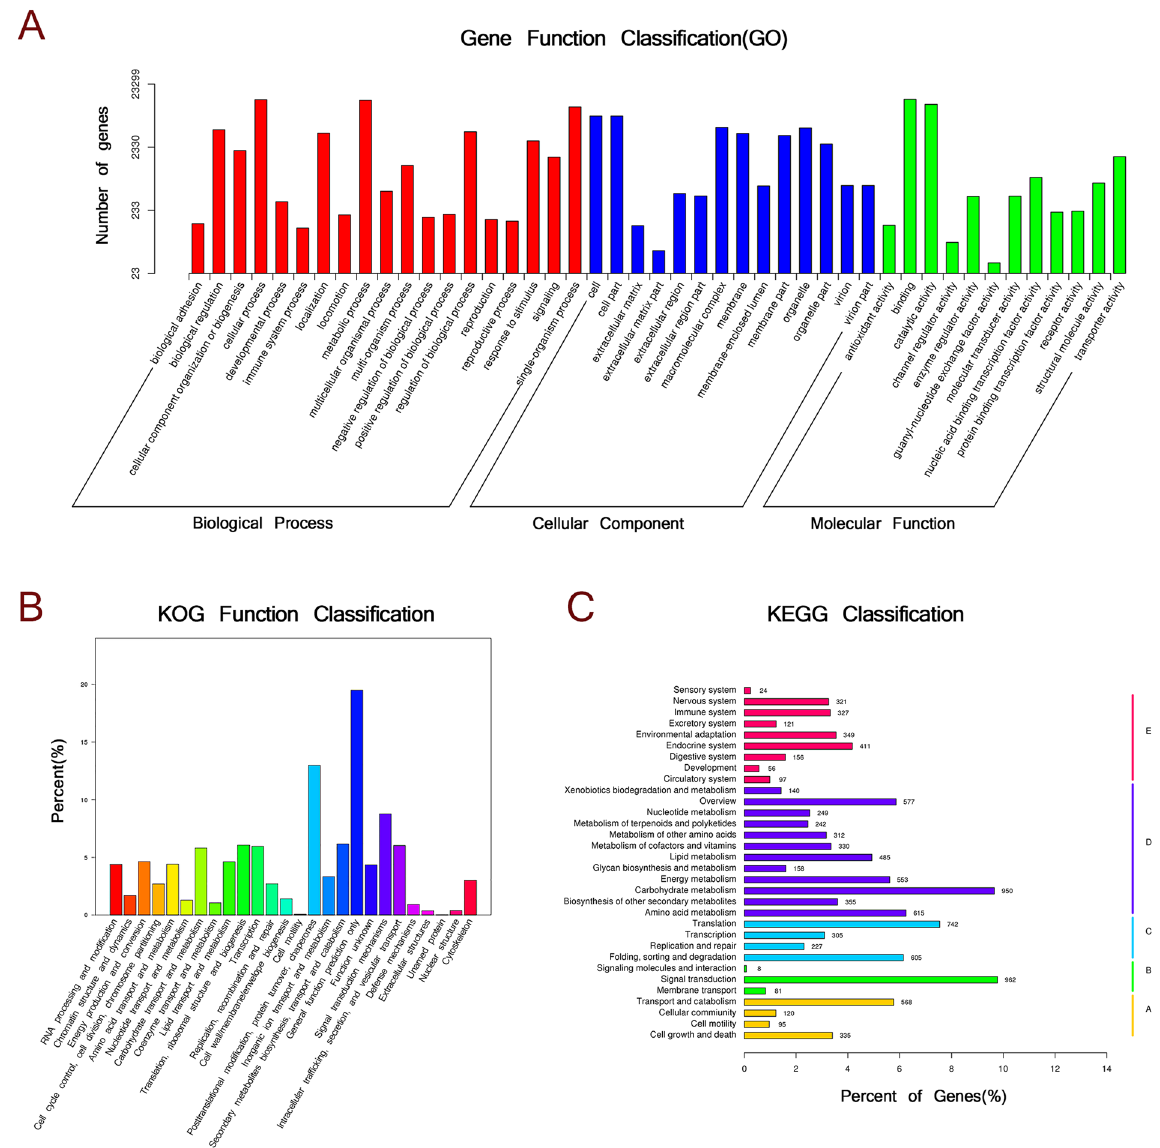
Figure 1. Functional categorization of unigenes specific to A . hypogaea following exposure to either M . anisopliae or F . axysporum , as determined from GO, COG and KEGG biological processes